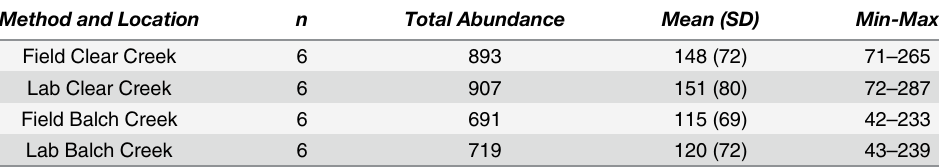
Table 1. Summary data from the investigation comparing the Field and Lab